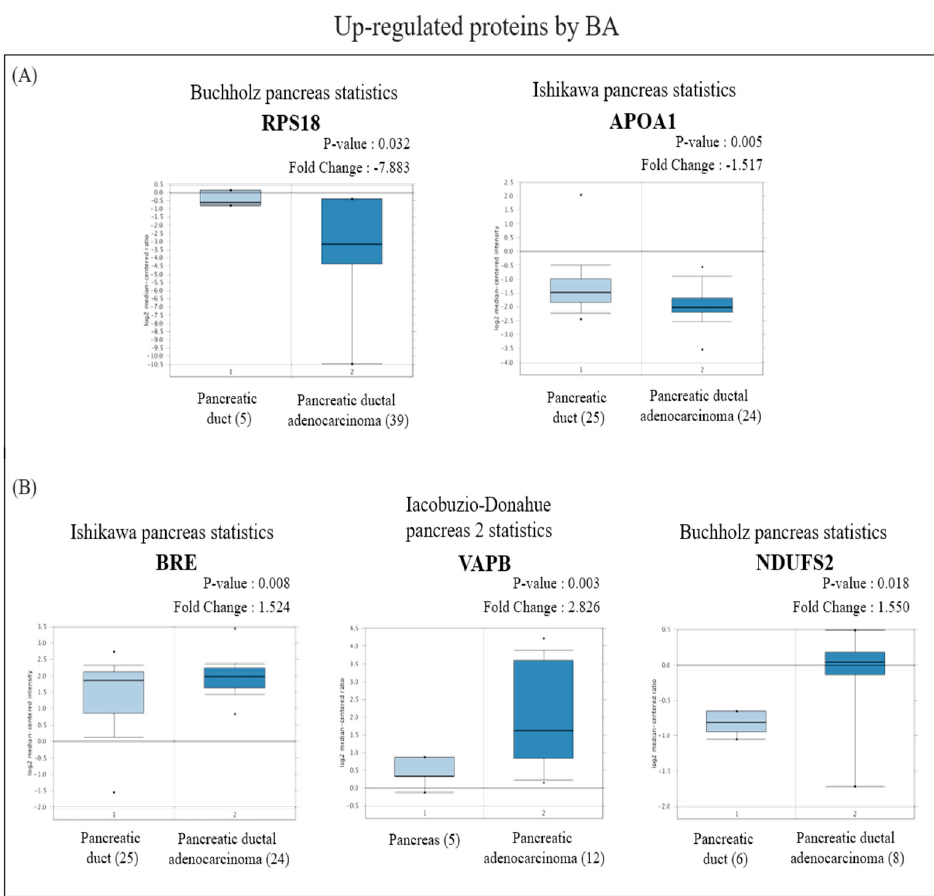
Figure 4. Analysis of the specific expressions of betulinic acid (BA)-induced upregulated proteins in clinically normal (left plot) and pancreatic ductal adenocarcinoma (PDAC; right plot) tissues using the Oncomine database. ( A ) Expressions of RPS18 ( p = 0.032) and APOA1 ( p = 0.005) were significantly lower in PDAC tissues compared to normal tissues. ( B ) Expressions of BRE ( p = 0.008), VAPB ( p = 0.003), and NDUFS2 ( p = 0.018) were significantly higher in PDAC tissues compared to normal tissues.